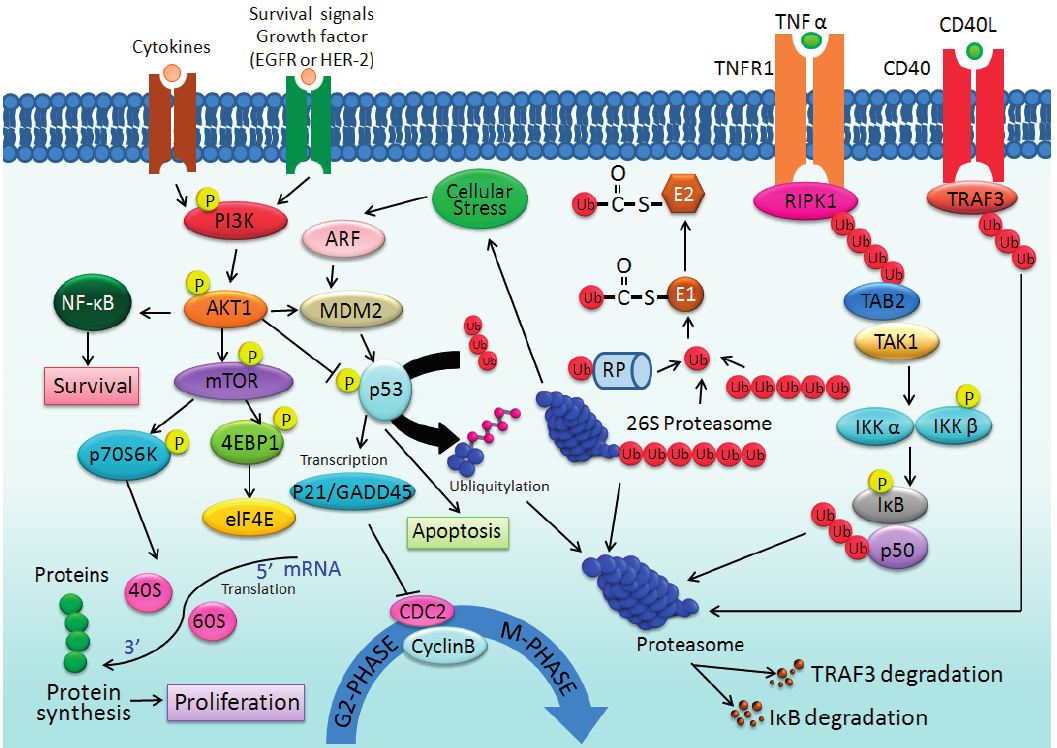
Figure 5. Schematic representation of some possible signaling pathways activated by SF-CSNPs which may regulate metabolism of proliferating cells through Ubiquitin C